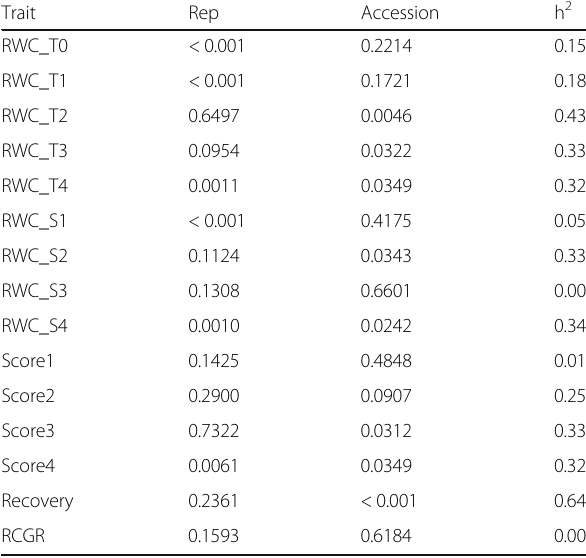
Table 1 Variance analysis and trait broad sense heritability